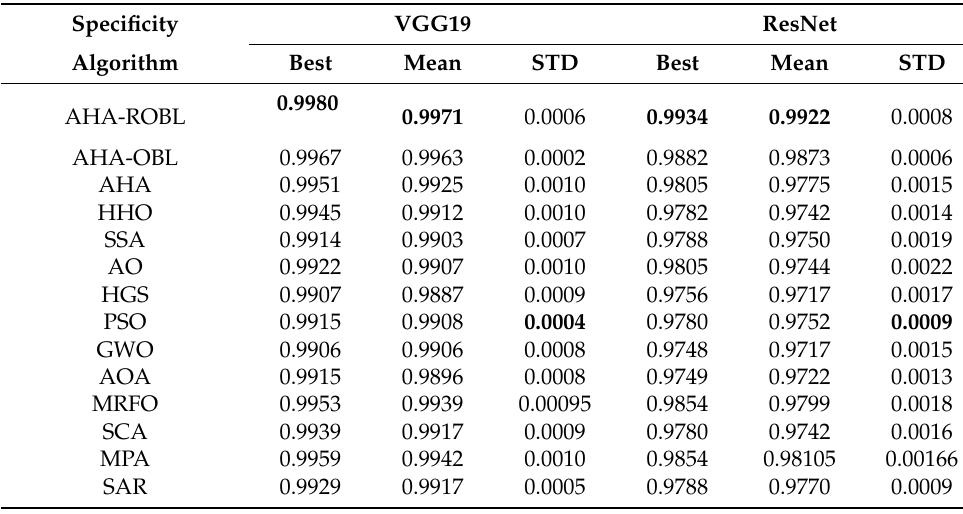
Table 7. Comparison of the performance of deep feature models of the AHA-ROBL with other recent optimizers versus avg.